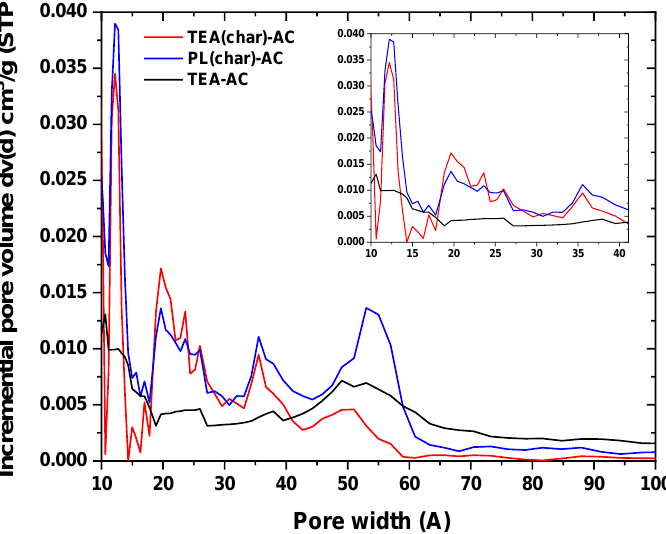
Figure 2. Pore size distributions of the synthesized AC samples.